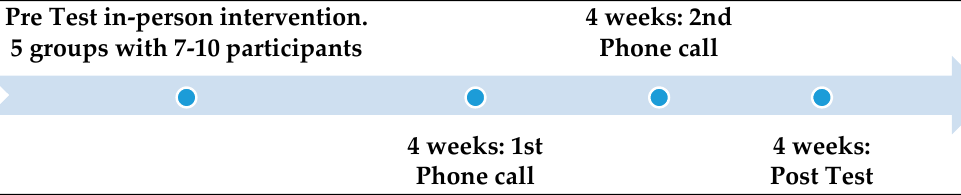
Figure 1. Study timeline over a 3-month oral health prevention intervention period.